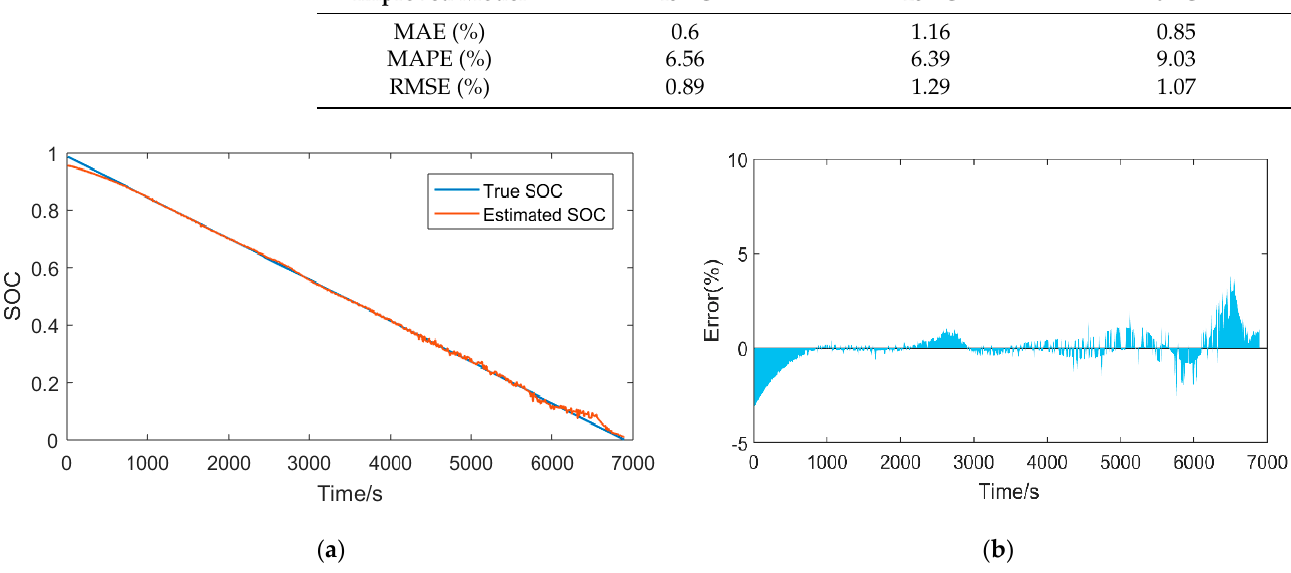
Figure 7. SOC estimation of the Bayes-BiLSTM model at 45 °C: estimated results ( a ) and estimated errors ( b ).